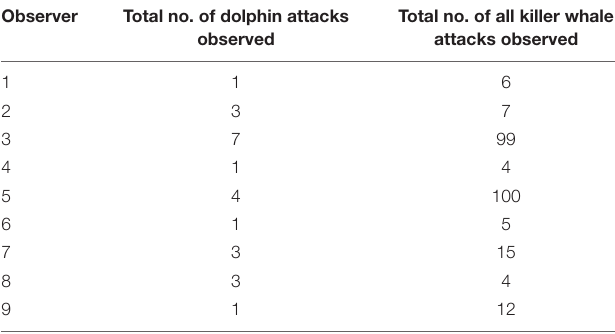
TABLE 2 | Results from interviews from nine observers who kept records of the total number of killer whale attacks on dolphins compared to total number of killer whale attacks on all marine mammal species